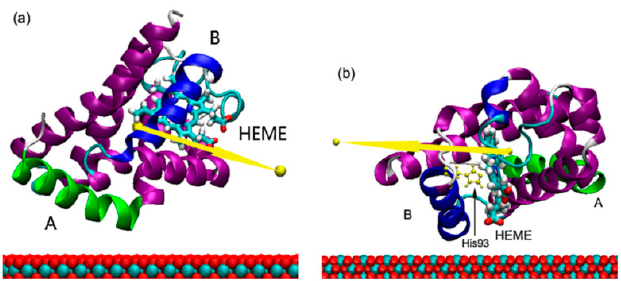
Figure 11. The adsorption configurations of myoglobin ( a ) on rutile TiO 2 (110) and ( b ) on rutile TiO 2 (001). The arrows represent the dipole direction of myoglobin. Reprinted from Ref. [131] with permission from Elsevier.